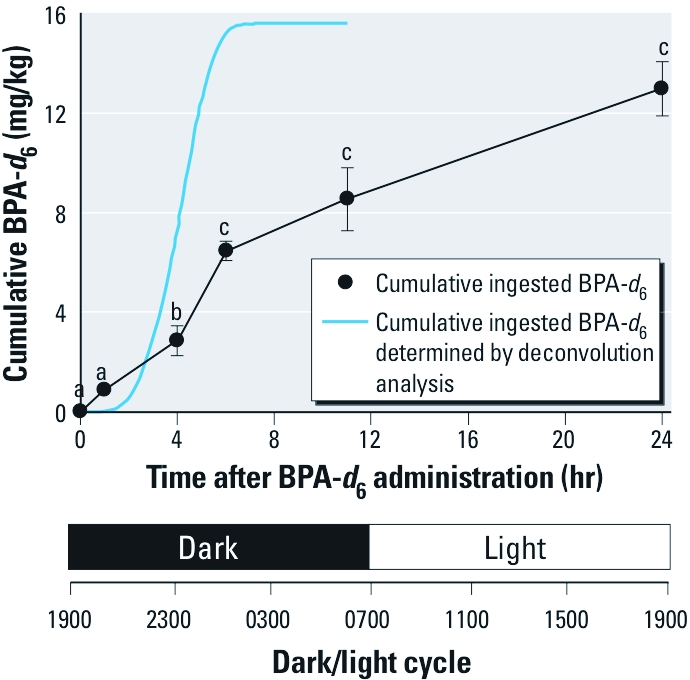
Cumulative diet exposure to BPA‑d6 versus time and night/day cycle estimated by amount of food consumed and by deconvolution. Deconvolution analysis was performed by using the oral bolus administration as a reference to evaluate the in vivo BPA‑d6 input rate (BW) over 11 hr (i.e, during the night). Time points with different superscripts are significantly different from each other based on log10 scale analysis (p < 0.01).